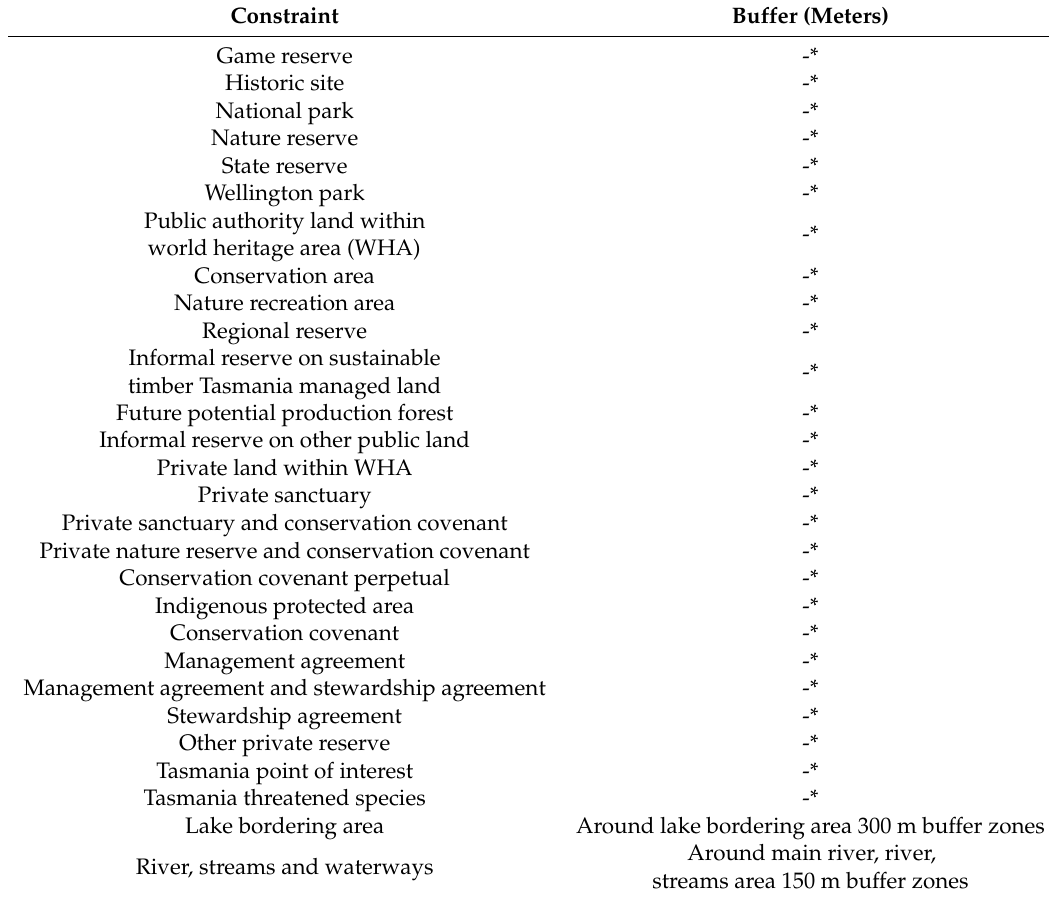
Table 2. List of the constraints to build the restriction model developed in this